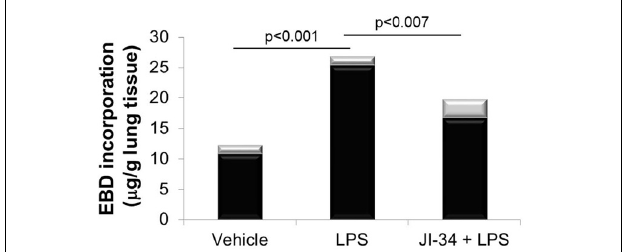
FIGURE 2 | Evans Blue Dye incorporation in lung tissue in 8–10 weeks old male C57BL6 mice ( n = 6 per group) treated i.t. with 0.65mg/kg LPS. Mice were pretreated either with vehicle (DMSO) or with JI-34 (100 μ g/kg) at 24 and 1h before receiving LPS. Data are given as mean ± SD (gray bars).